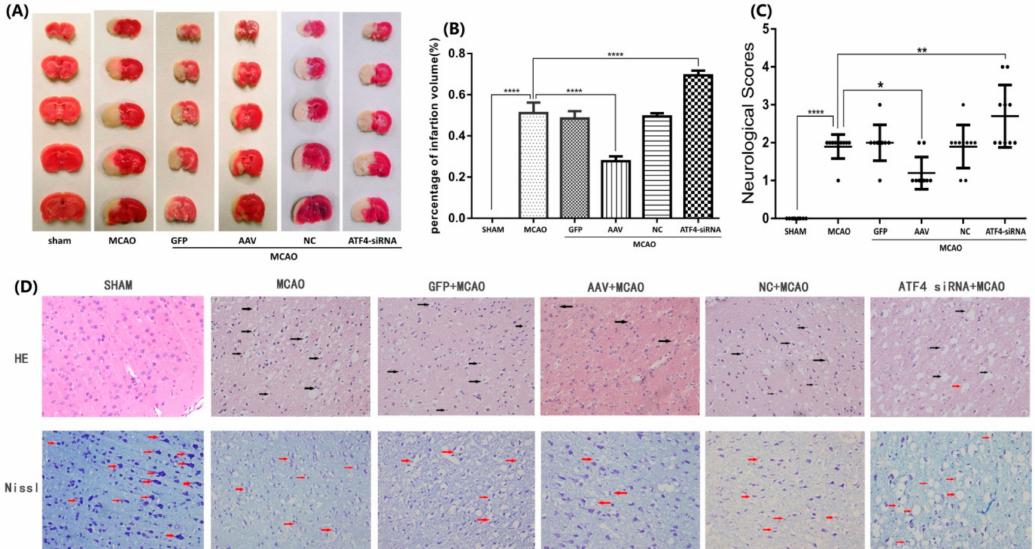
Figure 1. ATF4 prevents cerebral ischemia reperfusion injury in rats. ( A,B ) Infarct volume resulted to be significantly shrunk or enlarged upon AAV or ATF4 siRNA treatment compared to MCAO group. ( C ) Neurological scores was decreased or increased by AAV or ATF4 siRNA compared to MCAO group. ( D ) Representative HE staining and Nissl staining ( × 400) of AAV and ATF4 siRNA could e ff ectively improve or aggravate tissue and neurons injury in the cortex compared to MCAO group. The black arrows in HE staining marked the disorderly cytoplasmic loose, edema and karyopyknosis of the neurocytes; the red arrows in Nissl staining marked di ff erently changed nissl bodies or degenerated neurons. Error bars represent mean ± SD. (* p < 0.05, ** p < 0.01 and **** p < 0.0001 vs. indicated group). Panel A, D n = 5 in each group; Panel C n = 10 in each group. MCAO, middle cerebral artery occlusion-reperfusion; GFP, green fluorescent protein; AAV, ATF4 overexpression adeno-associated virus; siRNA, small interfering RNA; NC, negative control